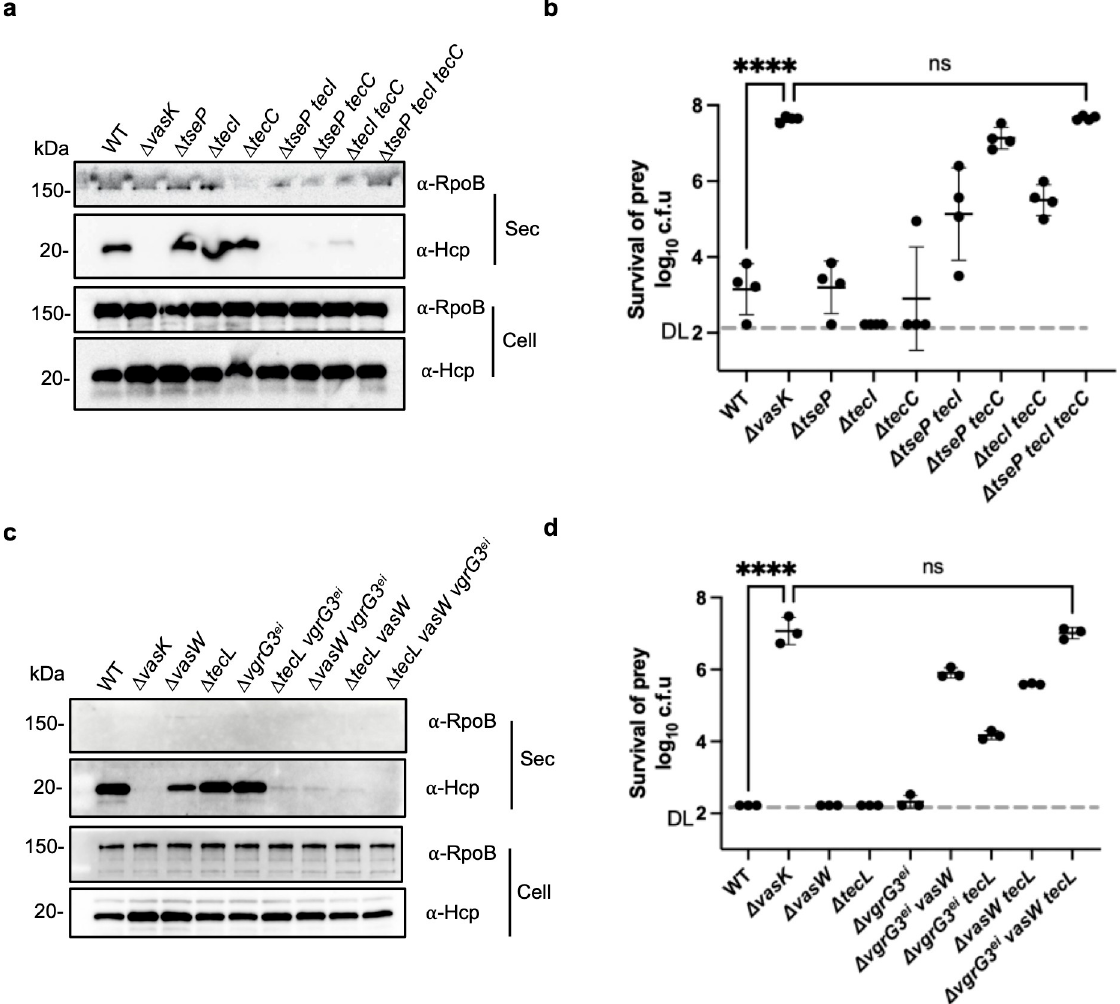
Fig 4. Effects of chaperone gene deletions on T6SS secretion. A, Western blot of Hcp secretion in chaperone deletion mutants. Chaperone genes tecI and tecC were deleted individually or in combination with the chaperone-independent effector gene tseP . Secreted samples were collected from aerobically growing cultures. Whole cell (Cell) and secreted samples (Sec) were subject to SDS-PAGE and Western blotting analyses. Signals were detected using anti-RpoB and anti-Hcp antibodies, respectively. The Δ vasK mutant serves as a T6SS null control. B, Competition analysis of chaperone gene deletion mutants against the E . coli prey. Error bars indicate the mean +/- standard deviation of four biological replicates. C, Western blot of Hcp secretion in chaperone deletion mutants of V . cholerae . Chaperone genes vasW and tecL were deleted individually or in combination with the vgrG3 effector-immunity gene pair Δ vgrG3 ei . VgrG3 is a chaperone-independent effector in V . cholerae . Signals were detected using anti-RpoB and anti-Hcp antibodies, respectively. D, Competition analysis of V . cholerae chaperone gene deletion mutants against the E . coli prey. Error bars indicate the mean +/- standard deviation of three biological replicates. For B and D , the killer-to-prey ratio is 10:1, and statistical significance was calculated using one-way ANOVA analysis. ���� P < 0.0001, ns: not significant. DL: detection